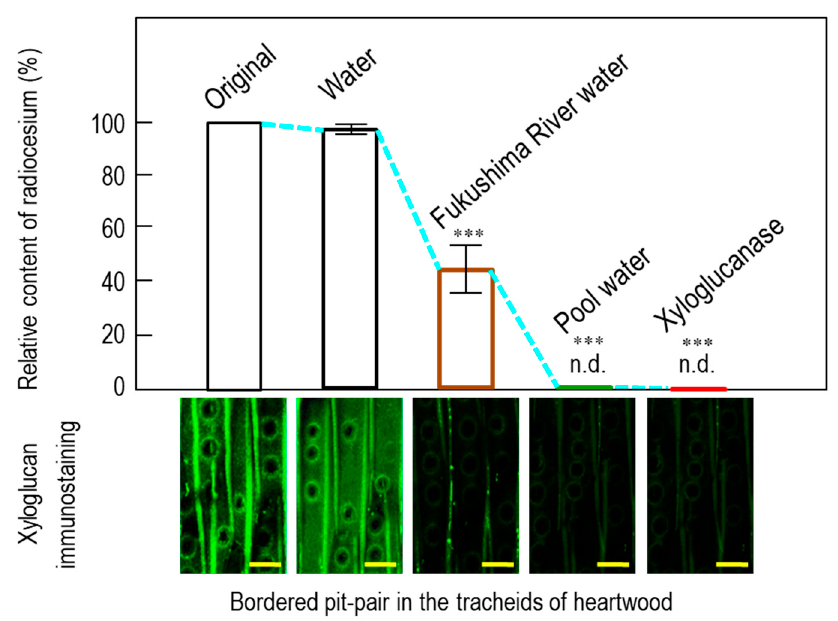
Figure 4. Effect of xyloglucanase on the removal of radiocesium during ponding in the heartwood section. Each tree sections (16 cm 2 × 10 cm in length) were ponded in each solution for 84 days. Immunostaining samples were obtained from the centers of each section. Significance at *** p < 0.001 levels compared with non-treated stems in Student’s t-test are indicated. Scale bar, 20 µ m.